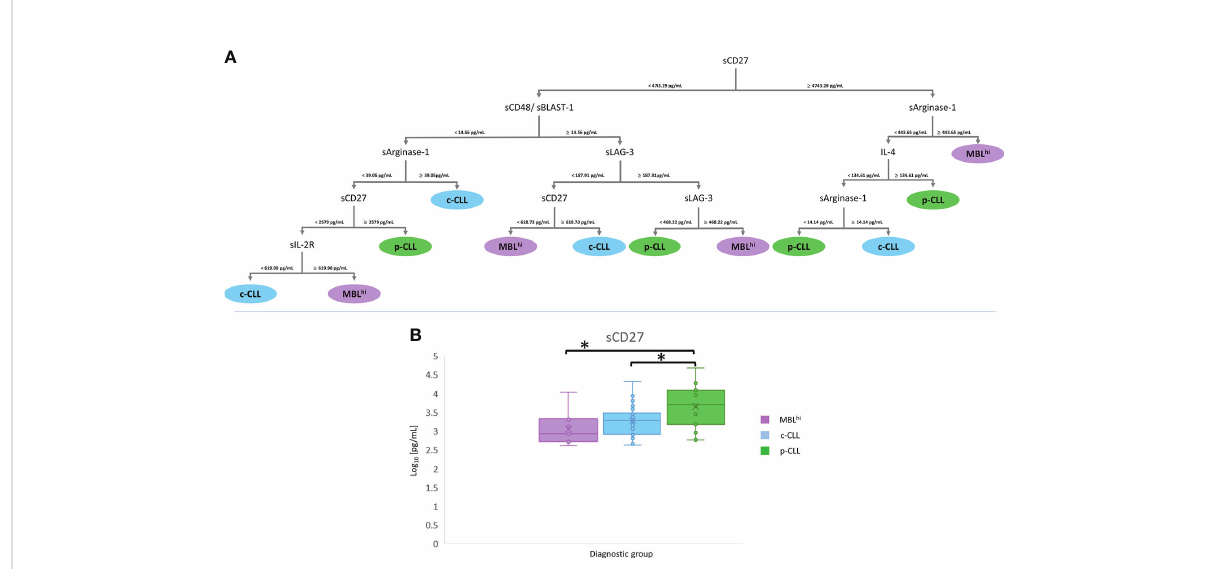
FIGURE 4 mRMR analysis: MBL hi vs. CLL stages. (A) Distribution and classi fi cation of MBL hi and c-CLL/p-CLL from quantitative soluble immune checkpoints and cytokines in serum. (B) Boxplot sCD27 in serum between MBL hi and CLL stages (* p – value <